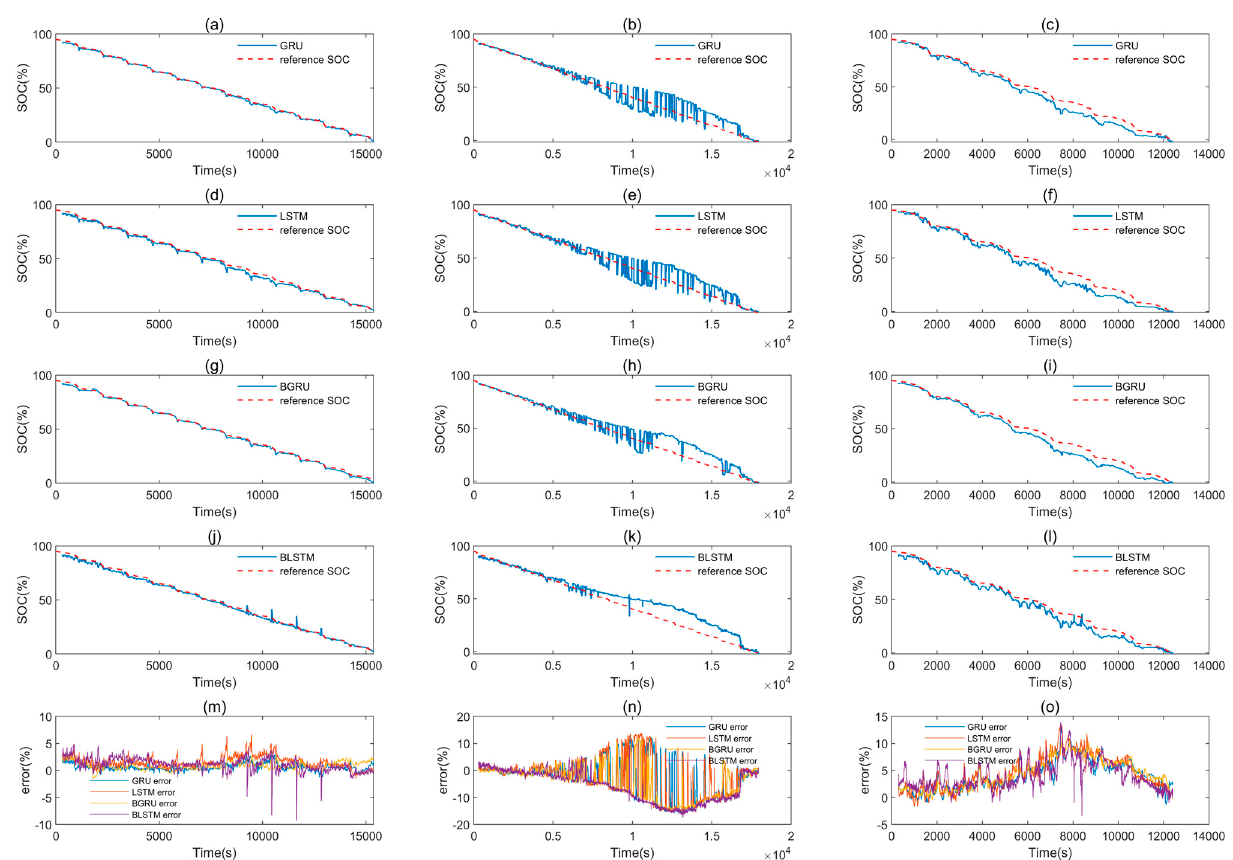
Figure 5. SOC estimation results of scenario 2: ( a – c ) SOC estimation using the GRU-based model;